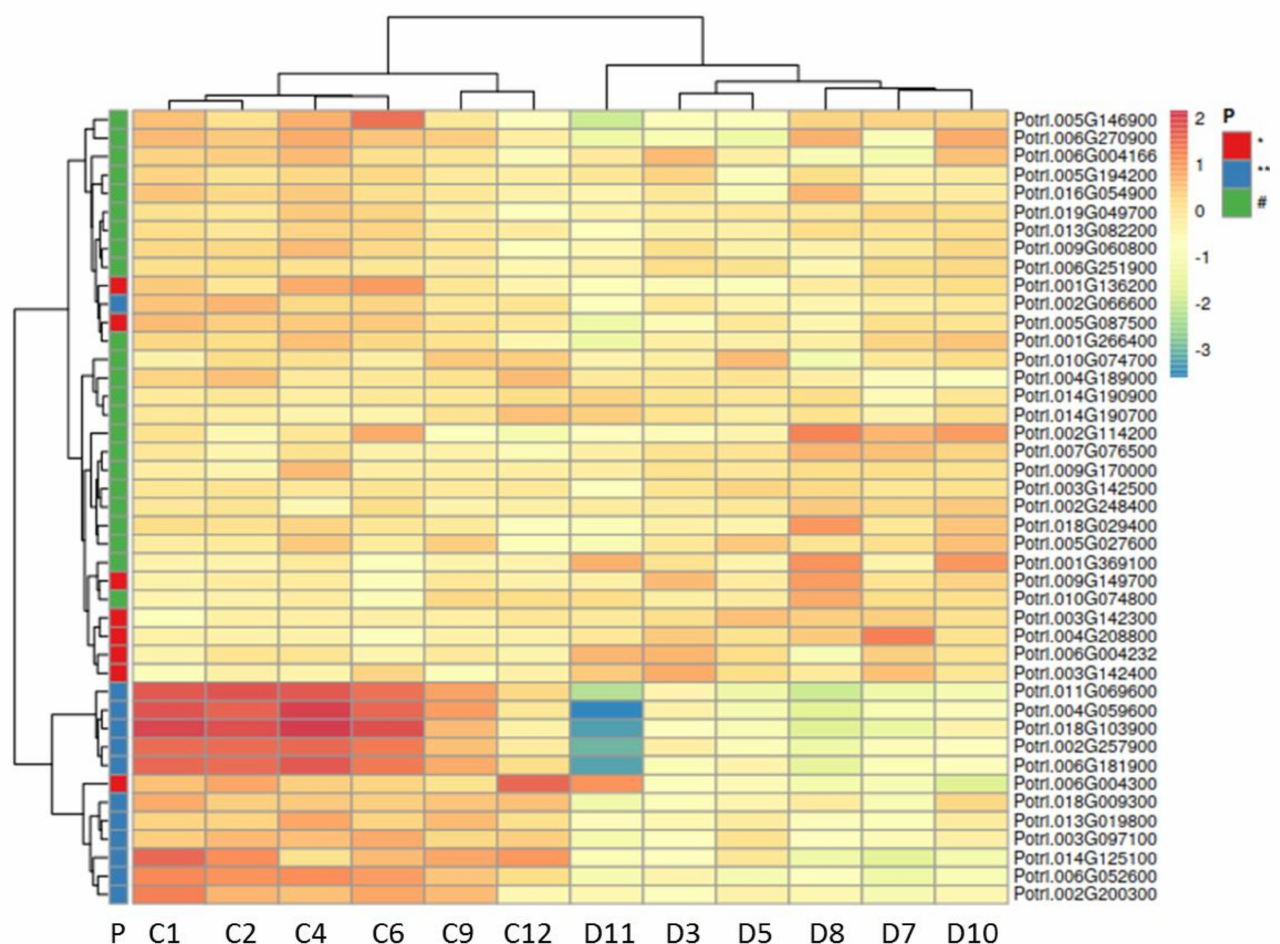
Figure 7. Hierarchical cluster analysis of genes related to cellulose synthesis in poplar wood (hybrid T89) of drought-stressed and non-stressed plants. Transcript abundances of genes annotated as “cellulose synthase” and “cellulose synthases-like” were retrieved from Supplement Table S1, and subjected to cluster analysis after transformation [ln(x + 1)] using Ward and Euclidian distance. P indicates p -values for the comparison of means of drought-stressed with non-stressed plants: * p < 0.05, ** p < 0.01, # not significant. C1, C2, C4, C6, and C9 are control samples and D11, D3, D5, D8, D7, and D10 are samples collected from drought-treated plants. Two main clusters were formed. The cluster on the top (31 annotated genes) was not or weakly upregulated in drought-stressed poplars. Transcript abundances of these genes were low. The lower cluster (12 annotations) was strongly expressed in non-stressed wood and massively downregulated in wood in response to drought stress. The heatmap was drawn using ClustVis